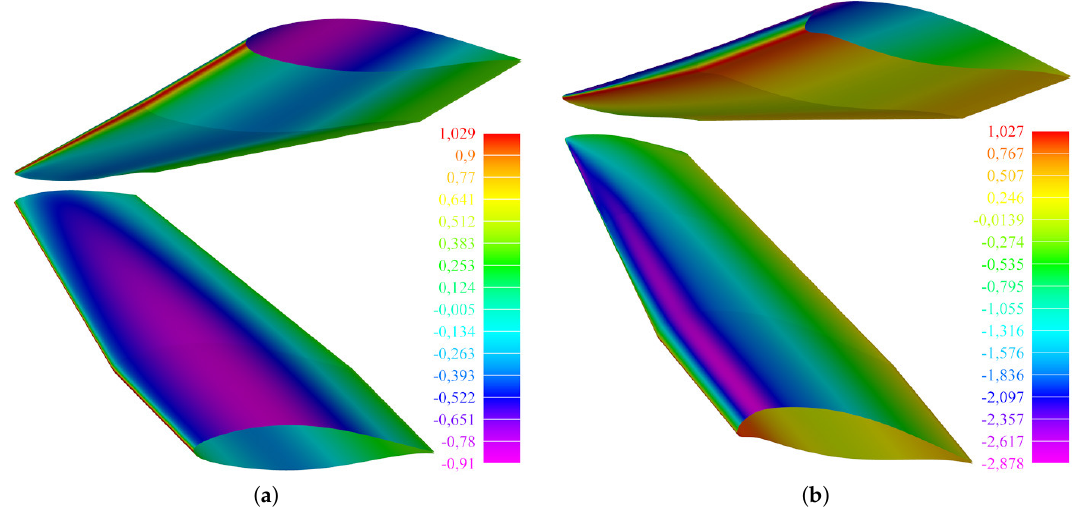
Figure 11. Pressure coefficient C p that correspond to undeformed shapes and placard speed conditions ( a ) and to morphing shapes and landing conditions ( b